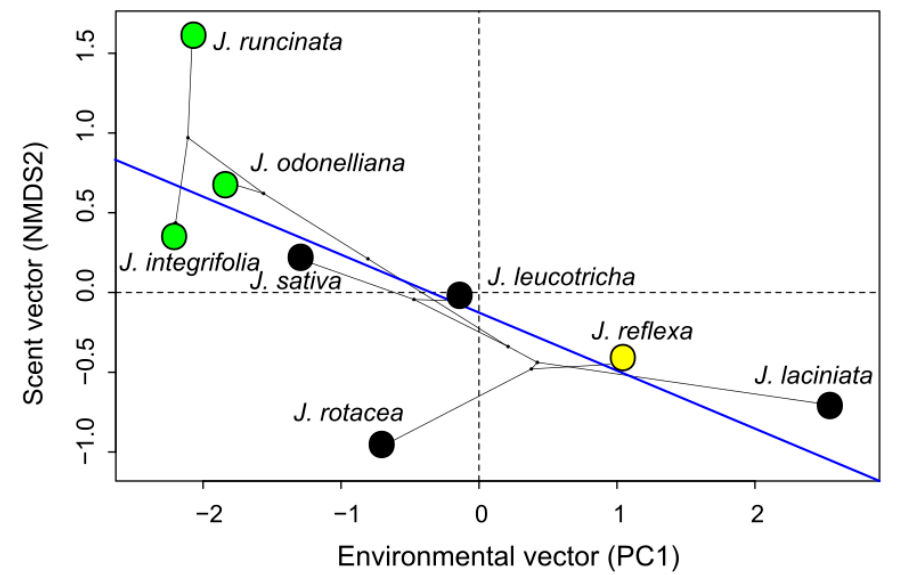
Figure 5. Evolutionary transitions along the scent axis in Jaborosa Juss. Phylogenetic generalized least squares (PGLS) correlation between environmental suitability and scent profiles. Blue line represents the slope. Different colors show pollination modes: green for hawkmoths, black for saprophilous flies and yellow for generalized small insects.